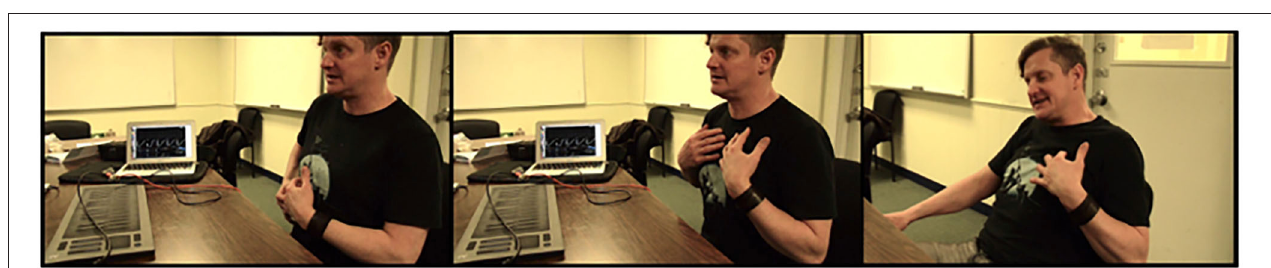
FIGURE 2 | Snapshots from Black’s interview when he demonstrated possible gestures on his torso.